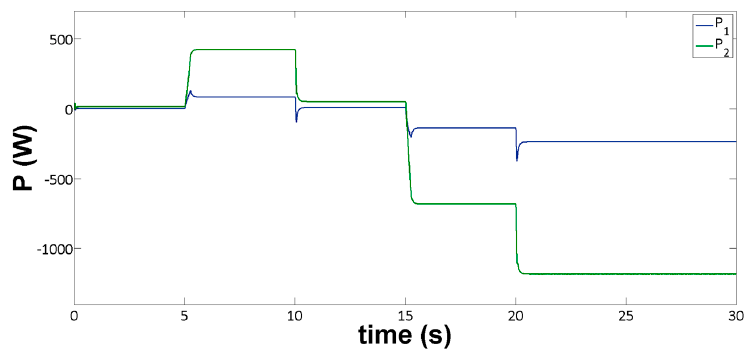
Figure 7. Power on each battery branch.